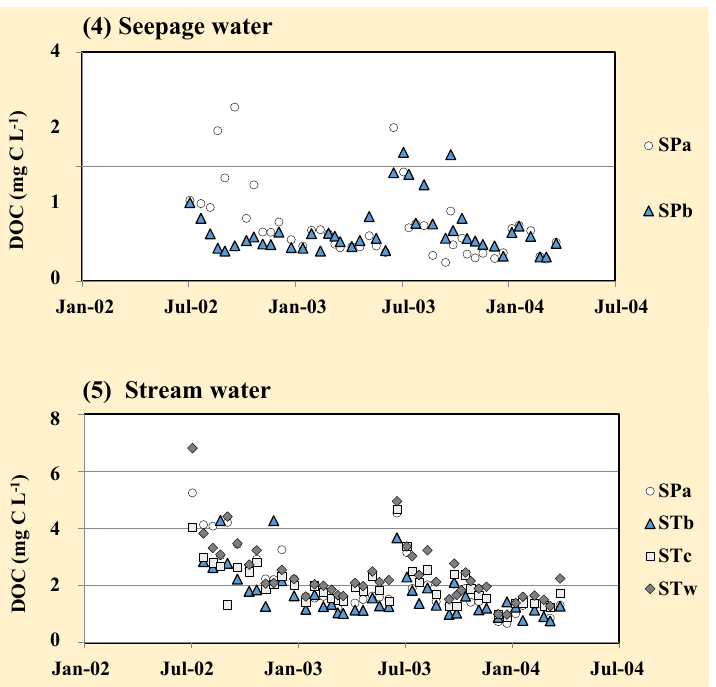
Figure 8. Seasonal variation of DOC concentrations for each sample type. See Figure 1 for the meaning of the abbreviations.